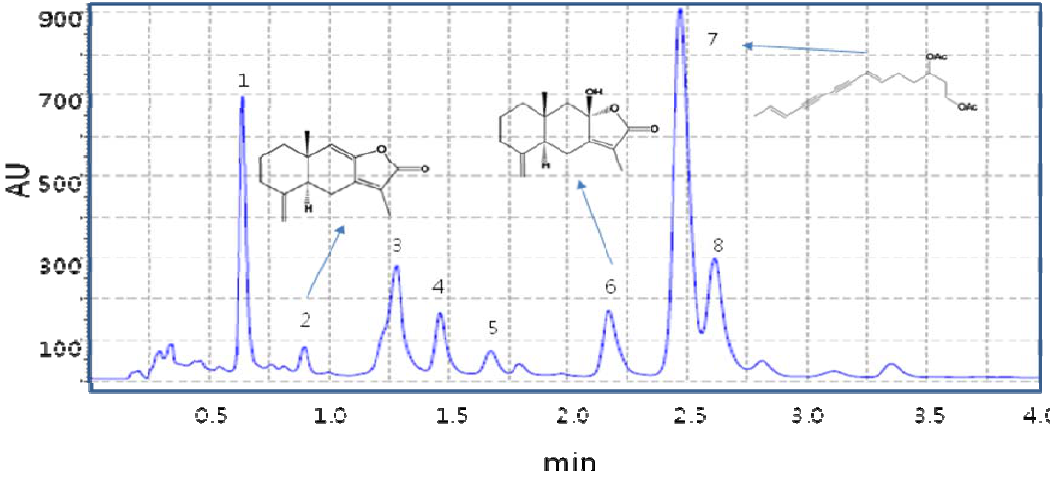
Figure 2. Smart HPLC chromatographic fingerprints of MeOH extract of A. japonica . The peaks marked with 2, 6 and 7 are atractylenolide III, atractylenolide I, (6 E ,12 E )- teradecadiene-8,10-diyne-1,3-diol diacetate (diacetylatractylodiol, TDEYA), respectively. The separation conditions are described in the Smart HPLC chromatographic